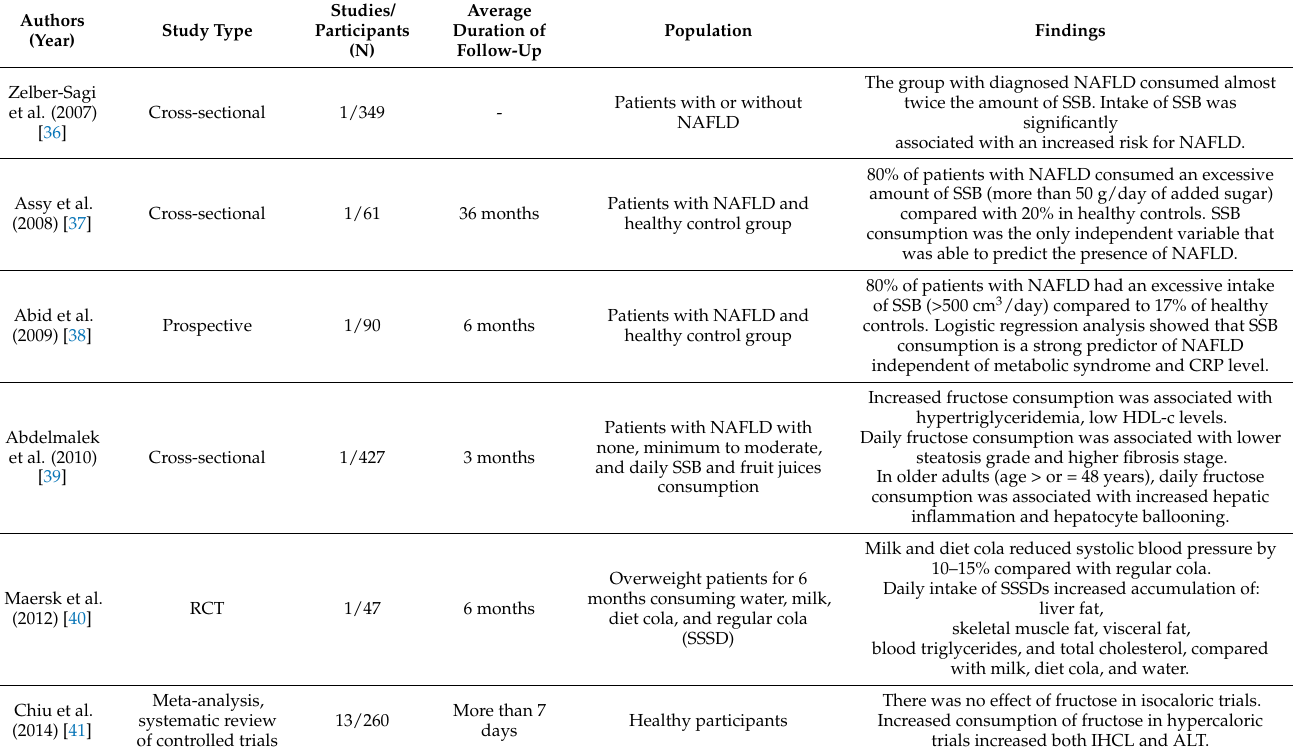
Table 1. The association between NAFLD and fructose